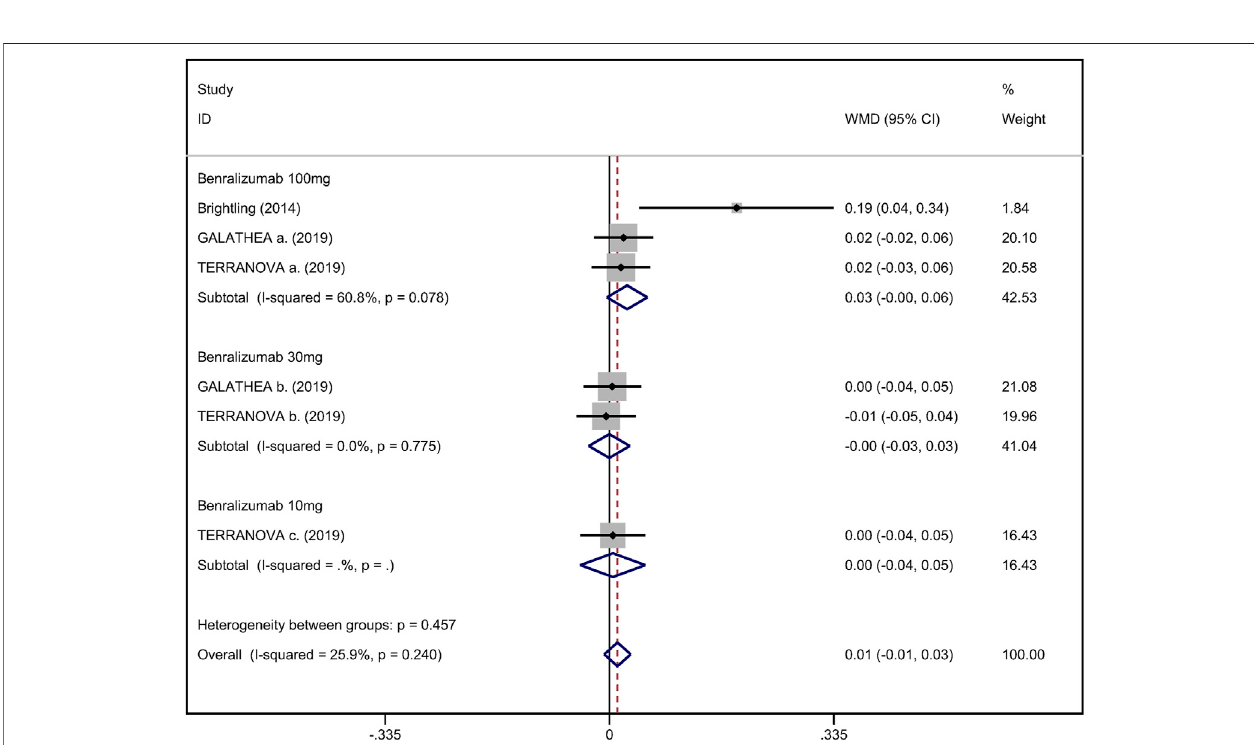
FIGURE 3 | Forest plot of pre-bronchodilator FEV 1 in eosinophilic COPD patients with anti-IL-5 therapy vs. placebo.